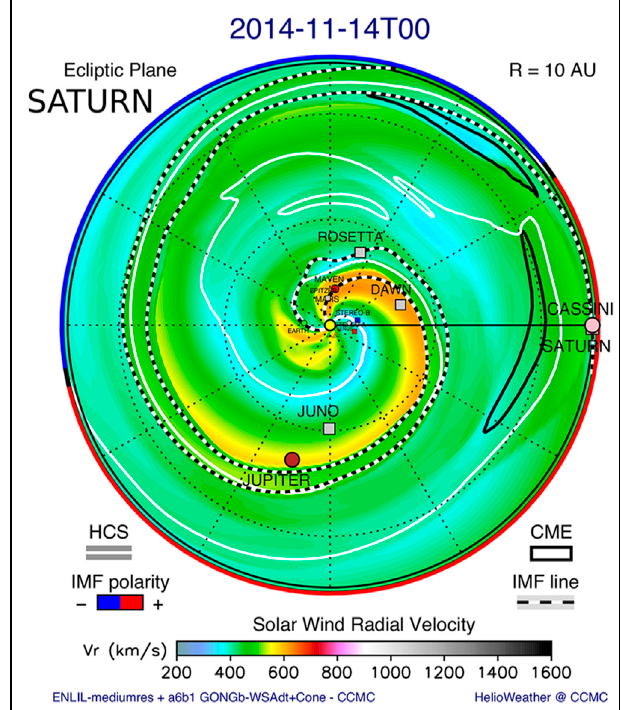
FIGURE 1 | Solar wind velocity in the ecliptic plane from a WSA-ENLIL + Cone model simulation showing the ICME propagation at Saturn. The ICME is marked as a black contour on the right side before Saturn. Time is given in the format YYYY-MM-DDThh. The full simulation is available at (Witasse et al., 2017) and http://ccmc.gsfc.nasa.gov under run ID